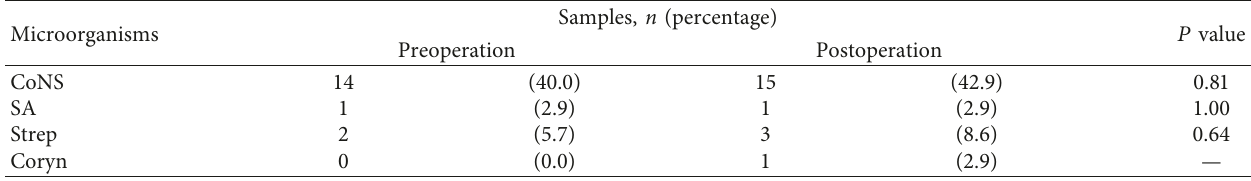
Table 1: Microorganisms isolated from the ocular surface before and after PRK. Samples, n Microorganisms